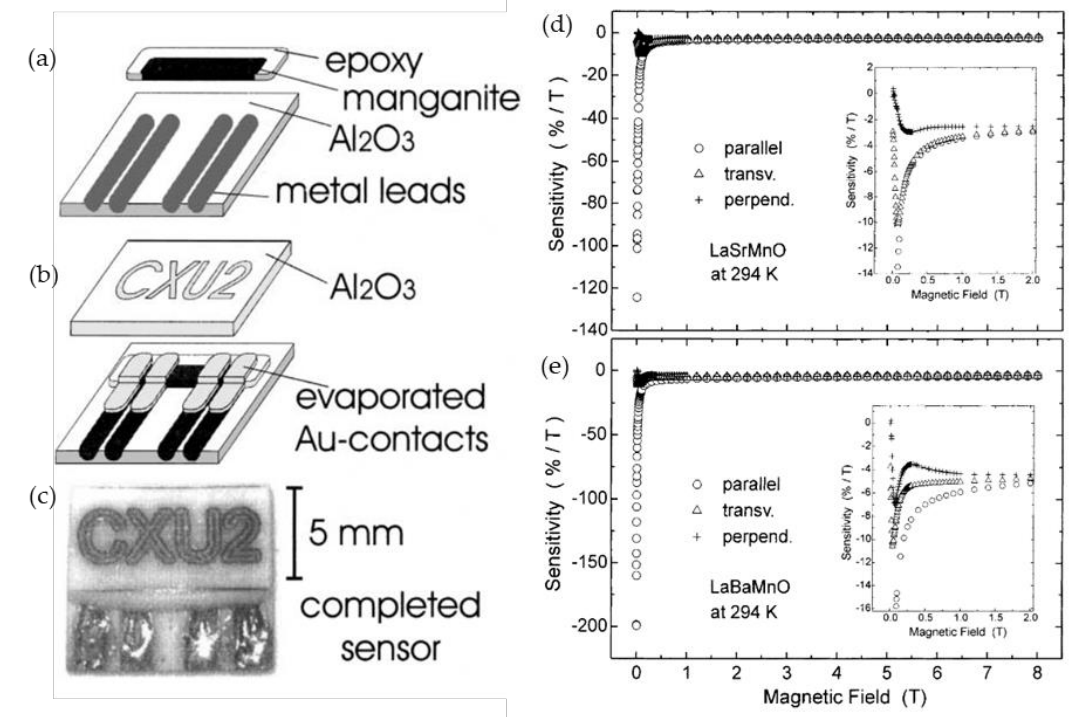
Figure 10. ( a − c ) Schematic drawing of LaBaMnO bulk sensor; ( d , e ) field sensitivity dependence on magnetic field applied in different directions (parallel, transverse and perpendicular) for LaSrMnO (upper panel) and LaBaMnO films (lower panel). Reprinted with permission from [80], copyright 2001 Elsevier.